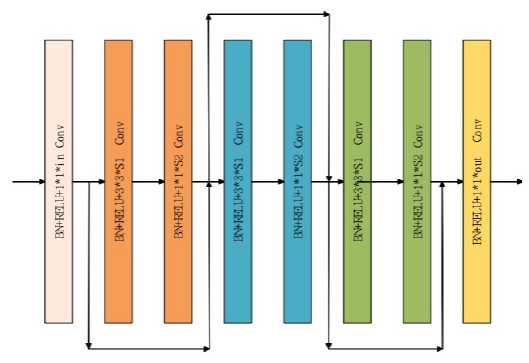
Figure 4. Description of the specific implementation of the DFR